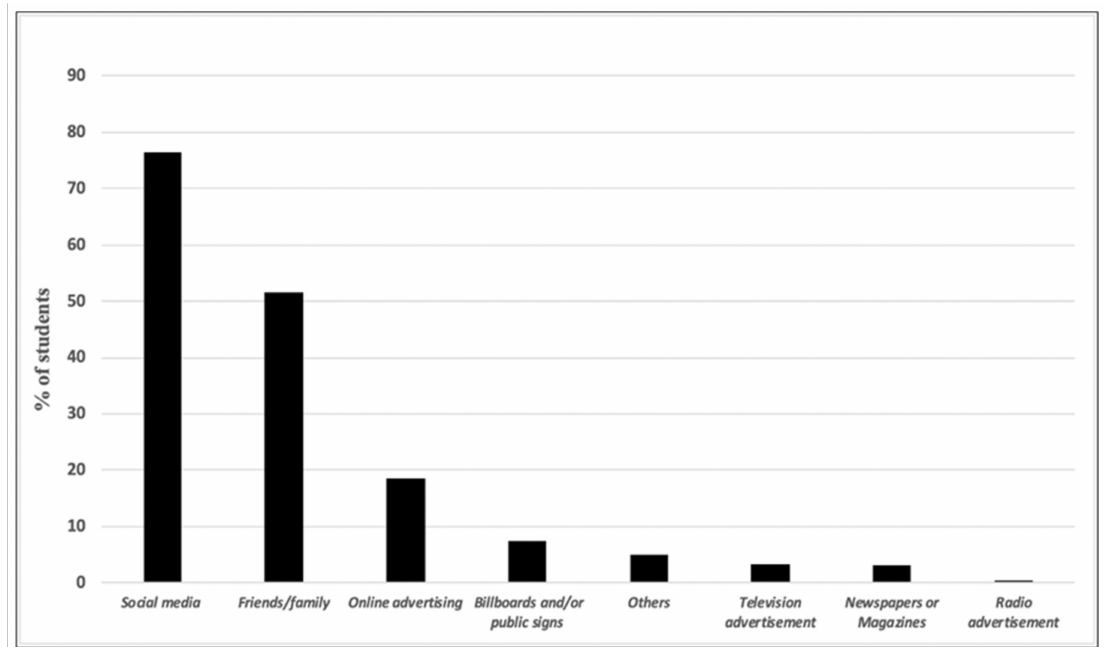
Figure 1. Source of knowledge regarding e-cigarettes among first-year university